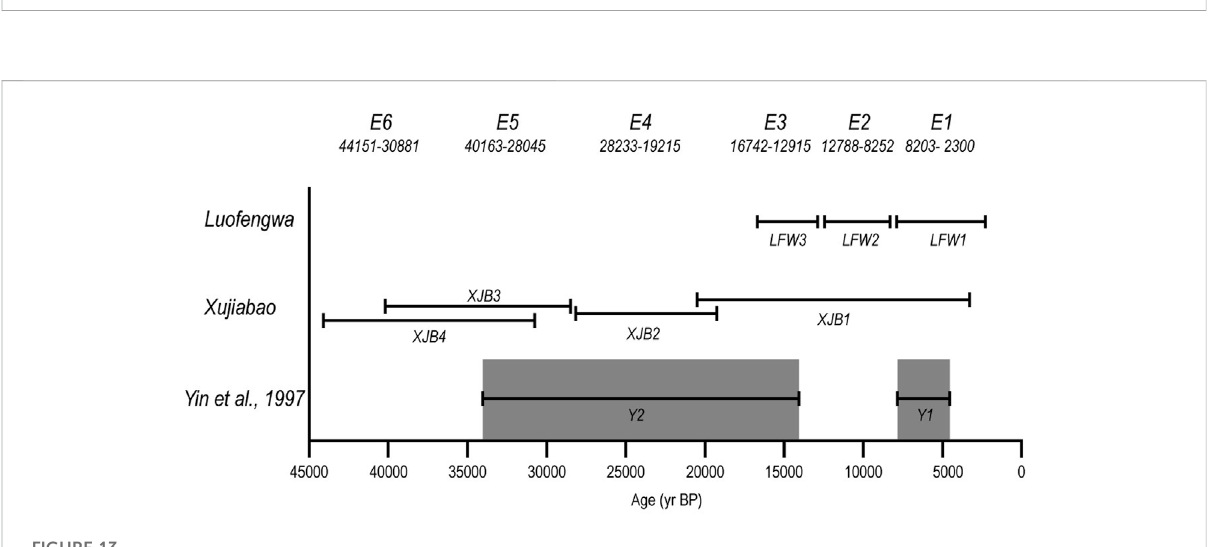
FIGURE 13 Late Pleistocene paleoearthquakes on the